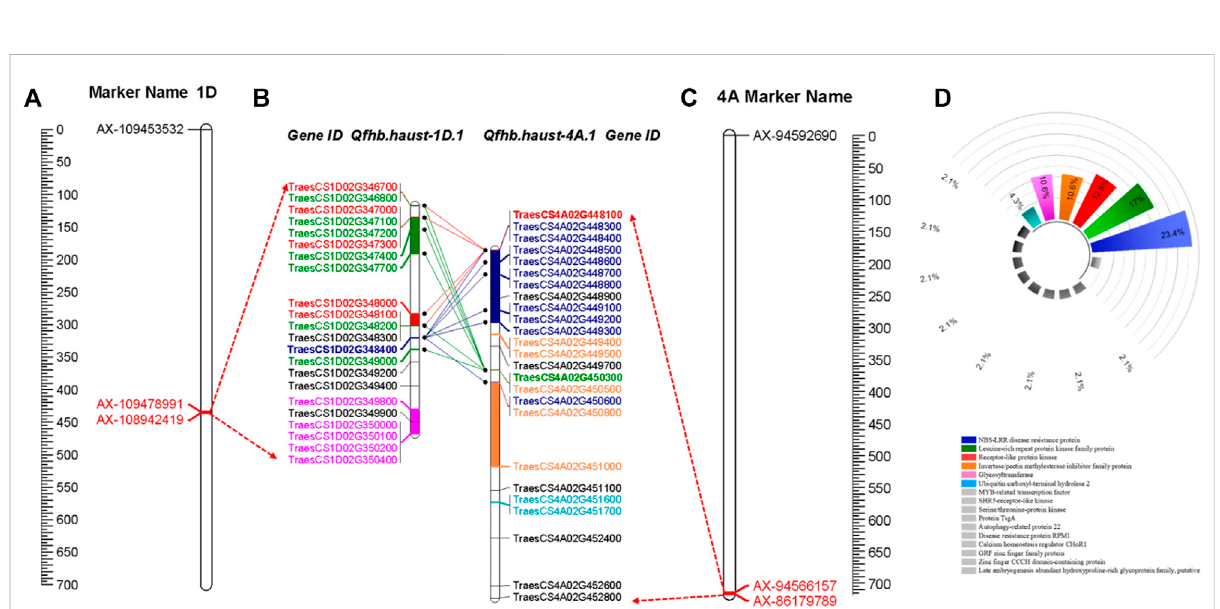
FIGURE 5 The distribution of the putative candidate genes associated with wheat head blight resistance located in the intervals of Qfhb. haust-1D.1 and Qfhb. haust-4A.1 . (A) The location of Qfhb. haust-1D.1 on chromosome 1D. (B) Putative candidate genes with the same function were shown in the same color, and the gene with the same function but located on different chromosomes were connected by the lines between the chromosomes. (C) Thelocationof Qfhb.haust-4A.1 onchromosome4A. (D) Theproportionofeachfunctionamongthese47putativecandidategenesandthe colors were the same color with the gene ID of (B)